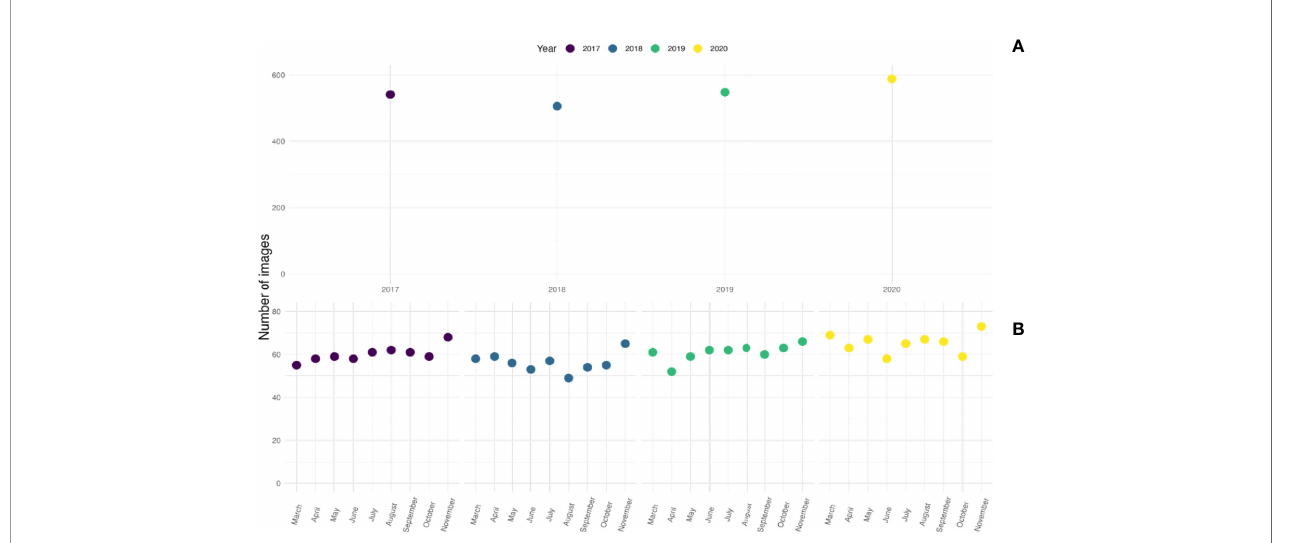
FIGURE 3 | Number of images available from the Sentinel-1 mission database (A) yearly and (B) monthly on the French Mediterranean